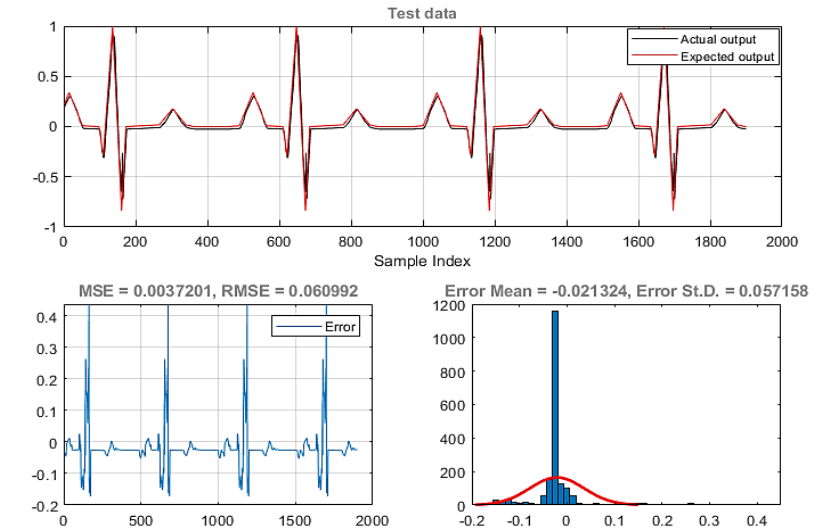
Fig. 5. The result of the actual, expected, error, and error histogram obtained with optimized upper MFs of FIS. Table 5. Results obtained using optimized lower and upper MFs of FIS.